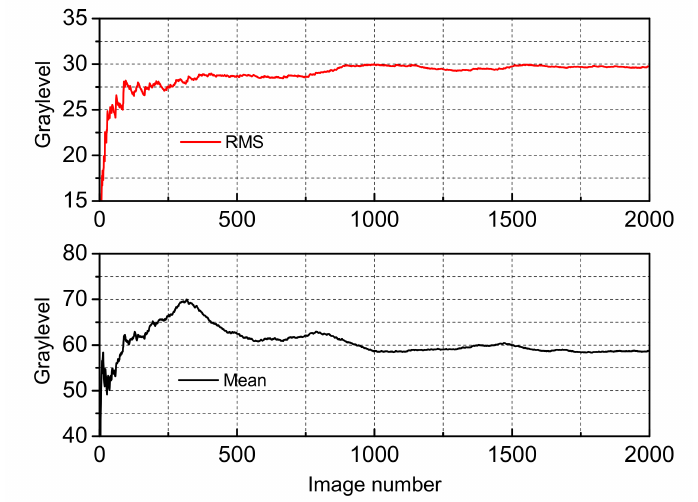
Figure 8. Convergence test of the mean value and the standard deviation of the grey levels ( σ = 2.23, u in = 10 m / s).